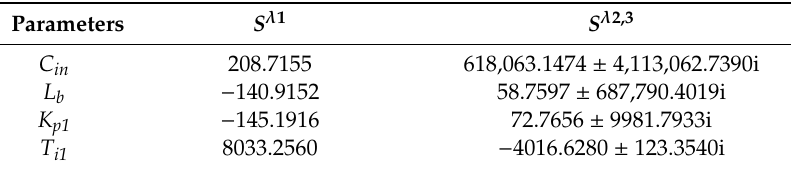
Table 3. Eigenvalue sensitivity of di ff erent parameters in